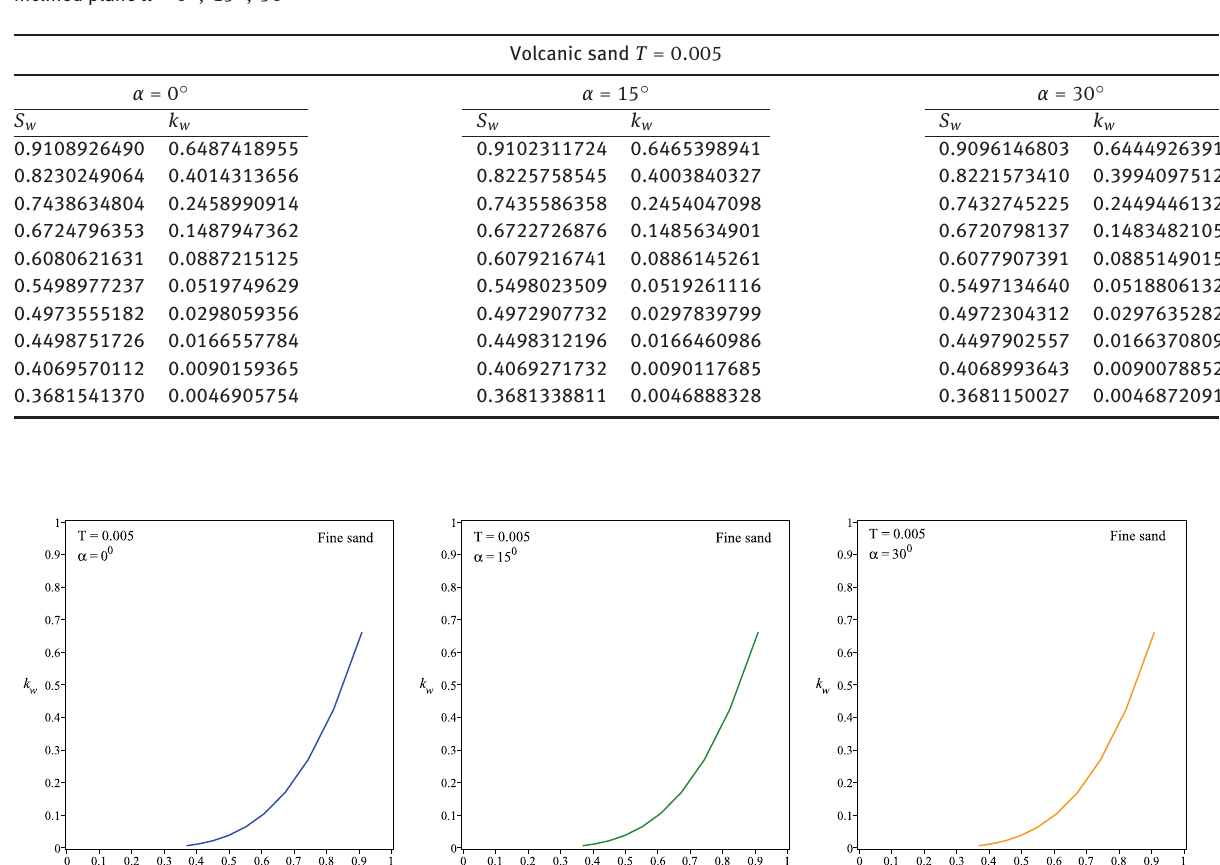
Table 7: Comparison of the numerical values for saturation vs. permeability in heterogeneous porous media for volcanic sand at different inclined plane α = 0 ◦ , 15 ◦ , 30 ◦